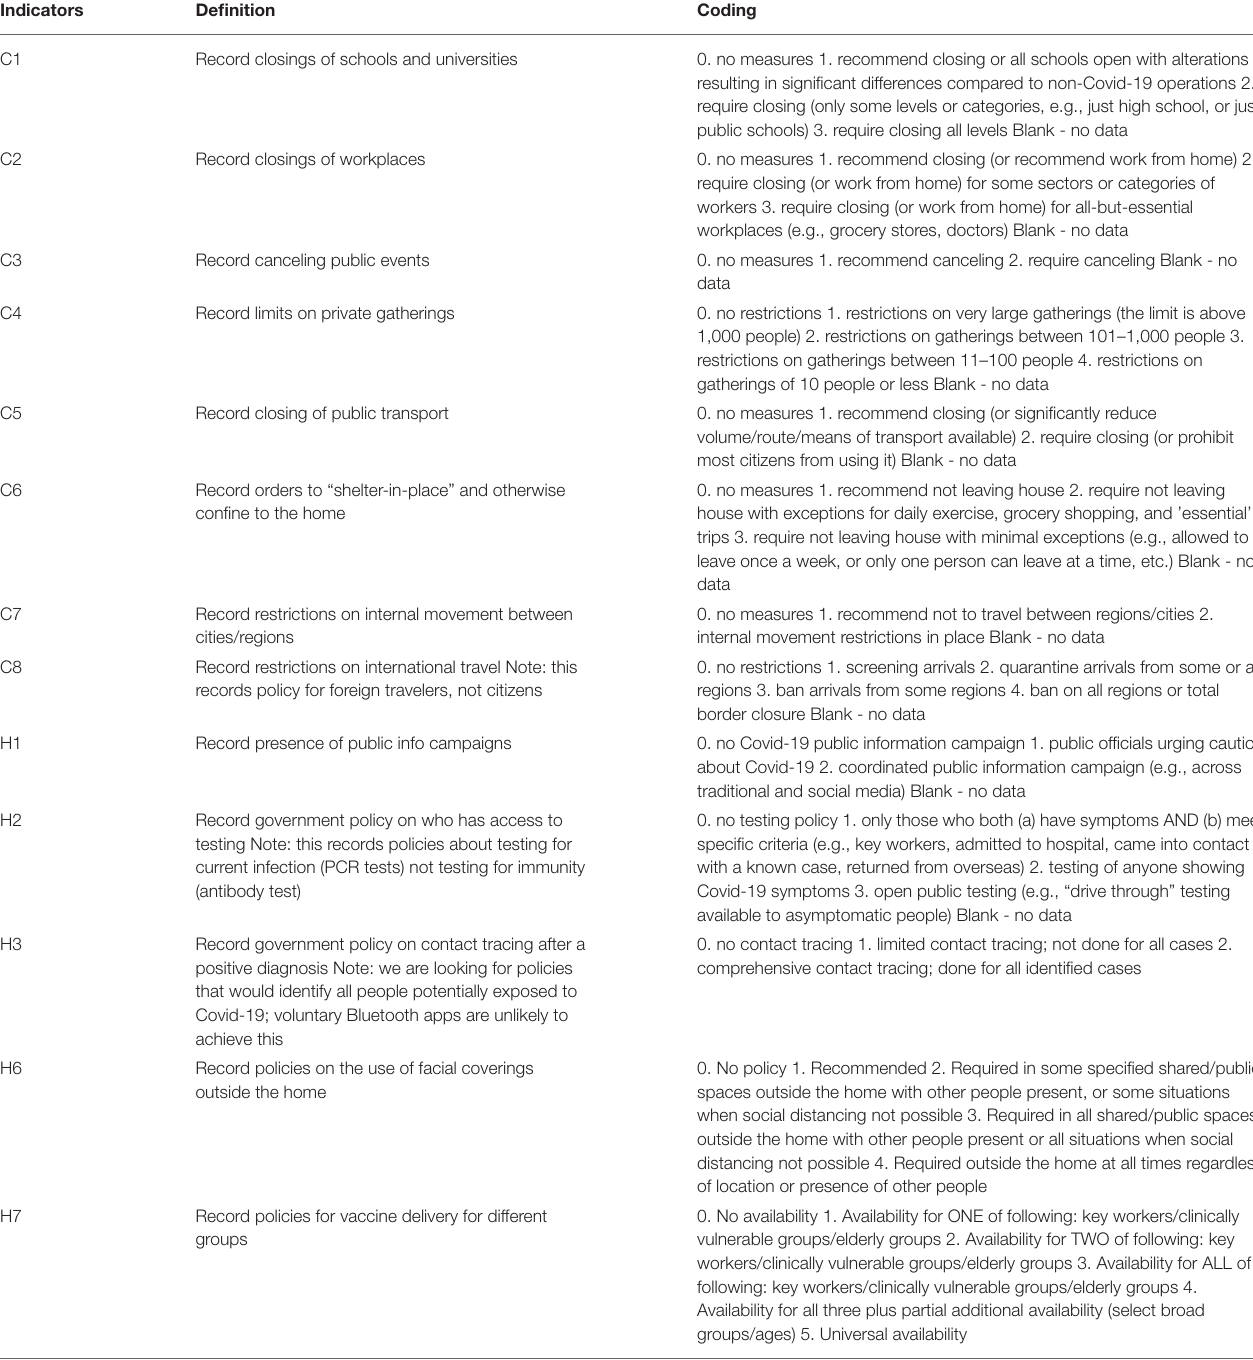
TABLE 1 | Indicators, definitions, and coding *